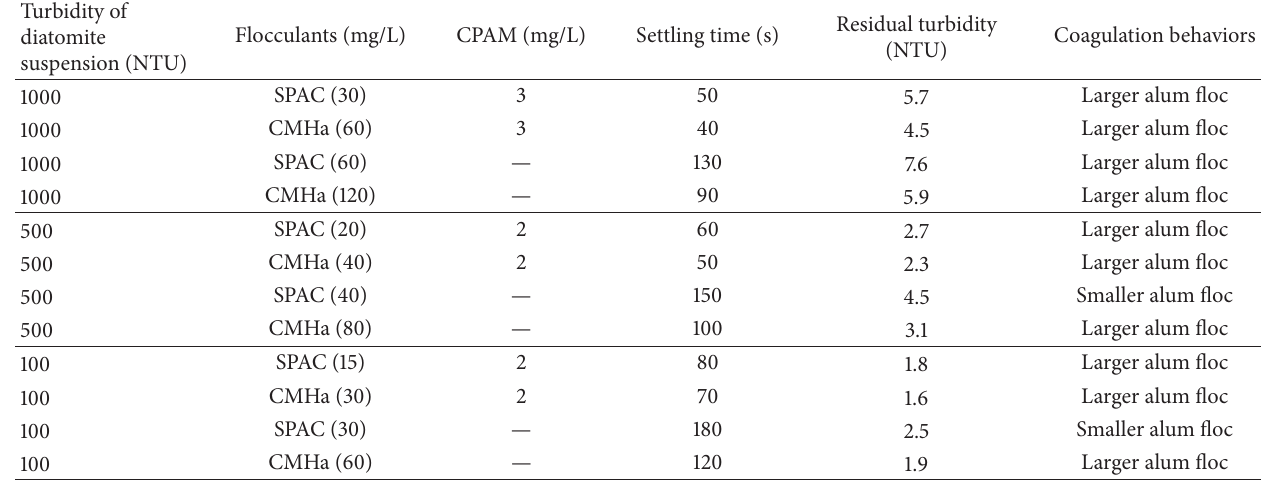
Table 7: The coagulation behaviors of CMHa versus PAC (100–1000 NTU diatomite suspension).